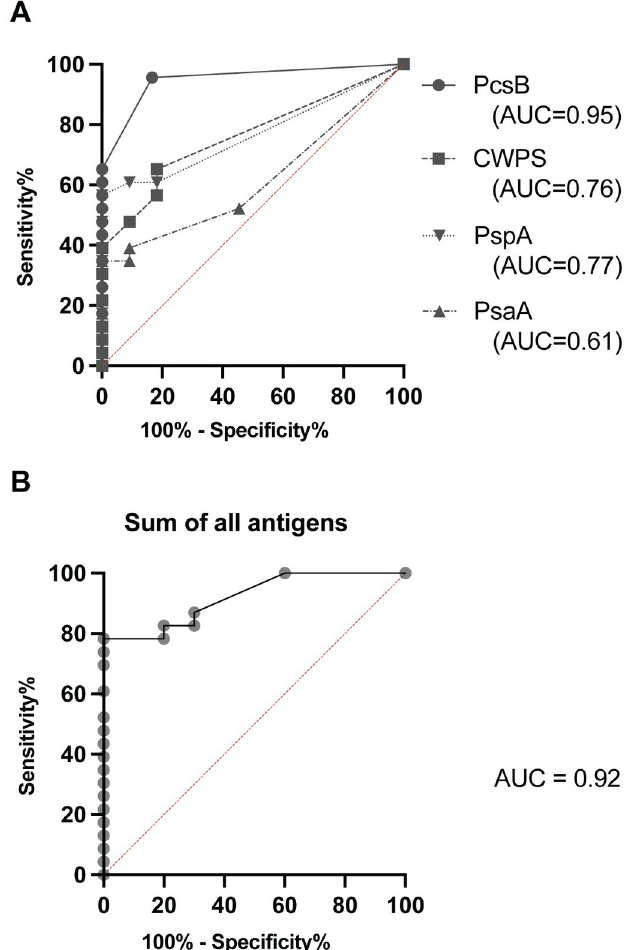
Fig 4. Receiver Operating Characteristic (ROC) curves for the discernment of patients with S . pneumoniae infections from patients with non- S . pneumoniae infections. ROC curves for the individual antigens PcsB (AUC = 0.95; circle), PsaA (AUC = 0.61; upright triangle), PspA (AUC = 0.77; inverted triangle), CWPS (AUC = 0.76; square)(A), and an ROC curve based on sum of the spots minus background for all antigens (B; AUC = 0.92). The diagonal red lines indicate no diagnostic value (AUC = 0.5); a perfect diagnostic test would have an AUC of 1.0.